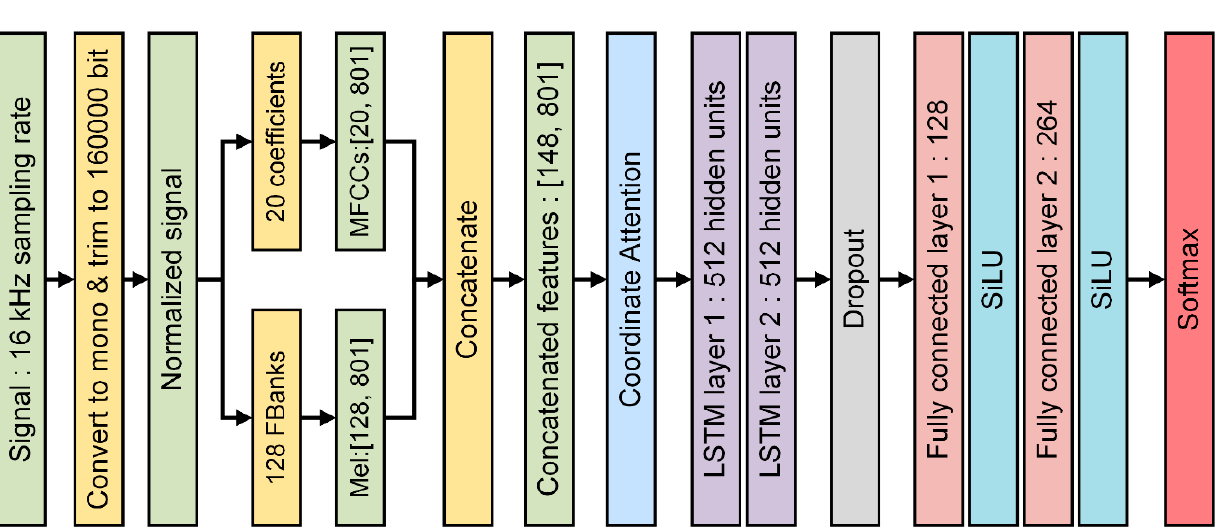
Figure 6. Workflow of LSTM.